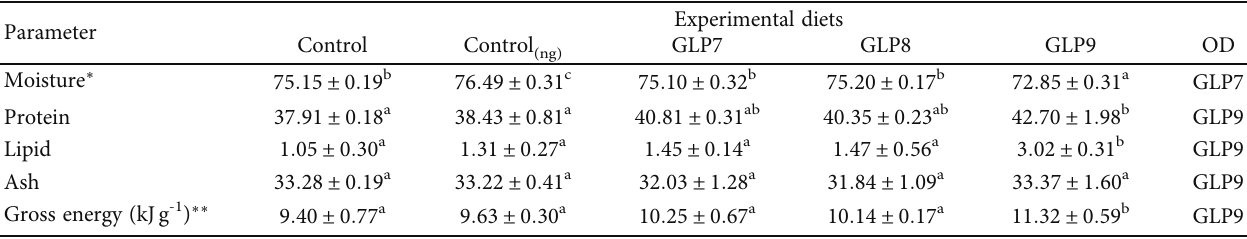
∗ Moisture is calculated based on % wet weight. ∗∗ Gross energy was calculated on the basis of 23.7kJg -1 of protein and 39.5kJ g -1 of lipid. Data in the same row with di ff erent superscripts are signi fi cantly di ff erent ( P < 0 : 05 ). Values are presented as mean ± SE . Control: basal diet; Control (ng) : basal diet +2% GOS; GLP7: GOS+ L. plantarum ( 2 % + 10 7 CFUg -1 diet); GLP8: GOS+ L. plantarum ( 2 % + 10 8 CFUg -1 diet); GLP9: GOS+ L. plantarum ( 2 % + 10 9 CFUg -1 diet); OD: optimum